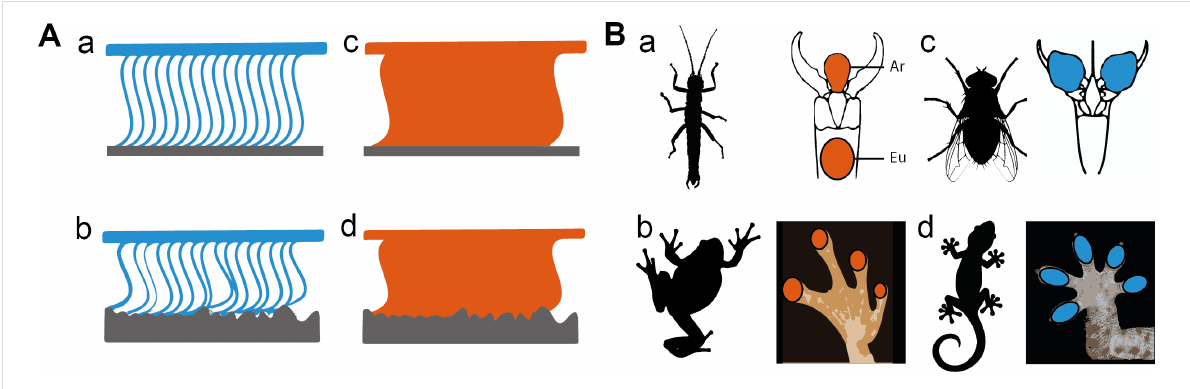
Figure 2: Attachment systems of animals. (A) Schematic representation of hairy (a, b) and smooth (c, d) attachment pads. Both systems provide adjustment to the surface profile of smooth (a, c) and corrugated (b, d) substrates. (B) Examples of smooth and hairy adhesive systems. (a) Smooth arolia (Ar) and euplantulae (Eu) in stick insects. (b) Smooth toe pads in frogs. (c) Hairy pulvilli in flies. (d) Hairy toe pads in geckos. Colours corre- spond to the type of attachment pad (cyan = hairy; orange = smooth). Figure 2A and the tarsus drawings in 2Ba and 2Bc were adapted with permis- sion from [1], R. G. Beutel et al., “Ultrastructure of attachment specializations of hexapods (Arthropoda): evolutionary patterns inferred from a revised ordinal phylogeny”, J. Zool. Syst. Evol. Res., with permission from John Wiley and Sons. Copyright © 2001 John Wiley & Sons. This content is not subject to CC BY